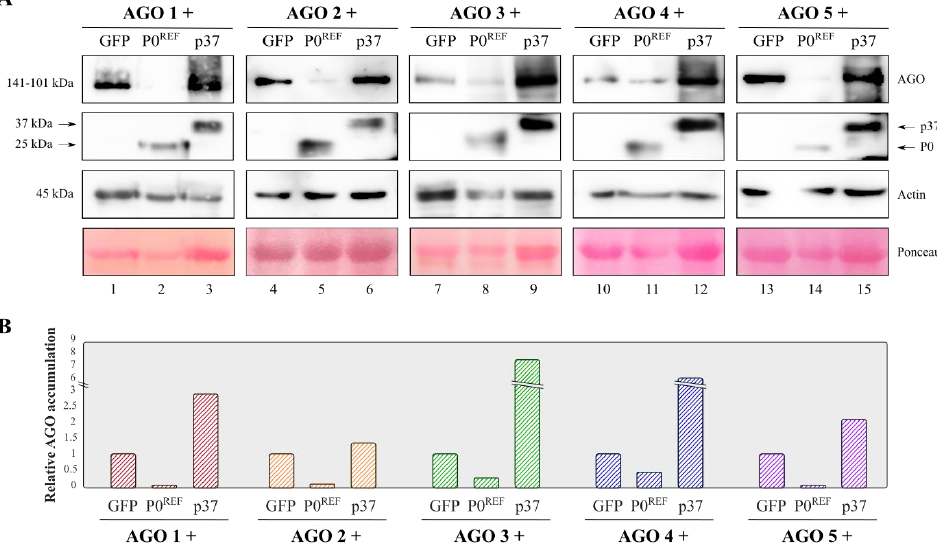
Figure 3. Analysis of accumulation levels of AGO proteins in the presence of PeVYV-5 P0 REF . N. benthamiana leaves were agroinfiltrated with constructs for expression of HA-tagged AGO1, AGO2, AGO3, AGO4 or AGO5 in combination with constructs directing expression of GFP, PeVYV-5 P0 REF - HAFlag or PLPV p37-HAFlag. At 3 dpif, protein extracts were prepared from agroinfiltrated leaves and subjected to Western blot analysis with an anti-HA antibody ( A ). Estimated protein sizes and positions of AGO, P0 REF and p37 tagged proteins are indicated at the left and right of autoradiograms, respectively. Ponceau S staining is shown below the blots as loading control. An anti-actin antibody was also employed both as additional loading control and to quantify relative accumulation levels of AGO proteins which are represented graphically in ( B ).